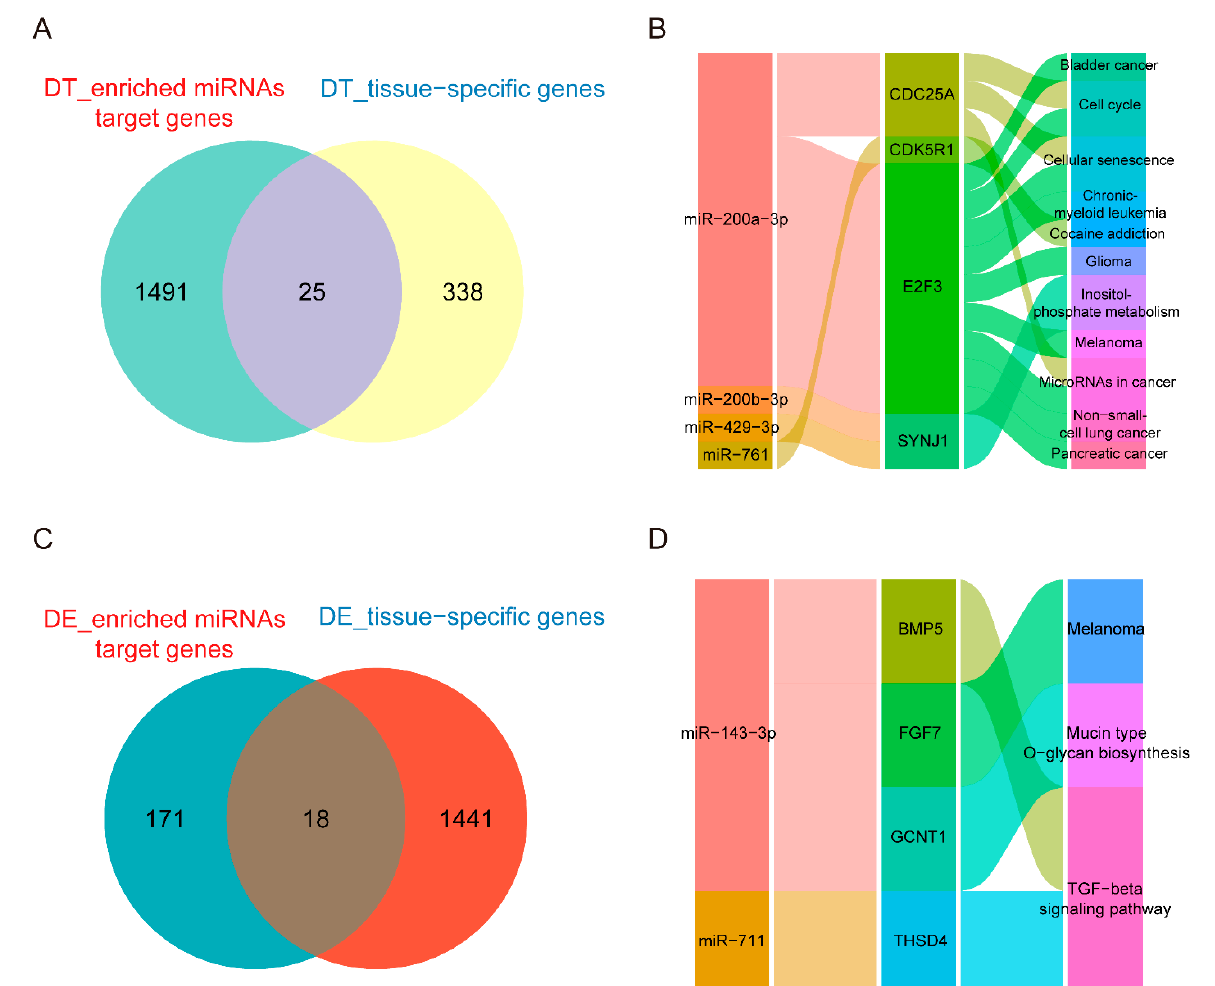
Figure 6. The regulatory analysis of miRNAs on pathways through tissue key genes in the donkey. ( A ) Venn diagram of key genes in donkey testis. The overlapping gene between target genes of tissue-enriched miRNAs and tissue − specific expressed genes in donkey testis were called donkey testis key genes. ( B ) Sankey diagram shows the KEGG pathway regulated by miRNAs through key genes in donkey testis. ( C ) Venn diagram of key genes in donkey epididymis. The overlapping genes between target genes of tissue-enriched miRNAs and tissue − specific expressed genes in donkey epididymis tissue were called donkey epididymis key genes. ( D ) Sankey diagram shows the KEGG pathway regulated by miRNA through key genes in donkey epididymis.